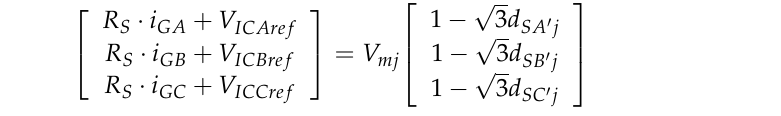
−V DC 3 − V DC 4 Table 2. Control key equations for four operation regions of phase A. Switching State I